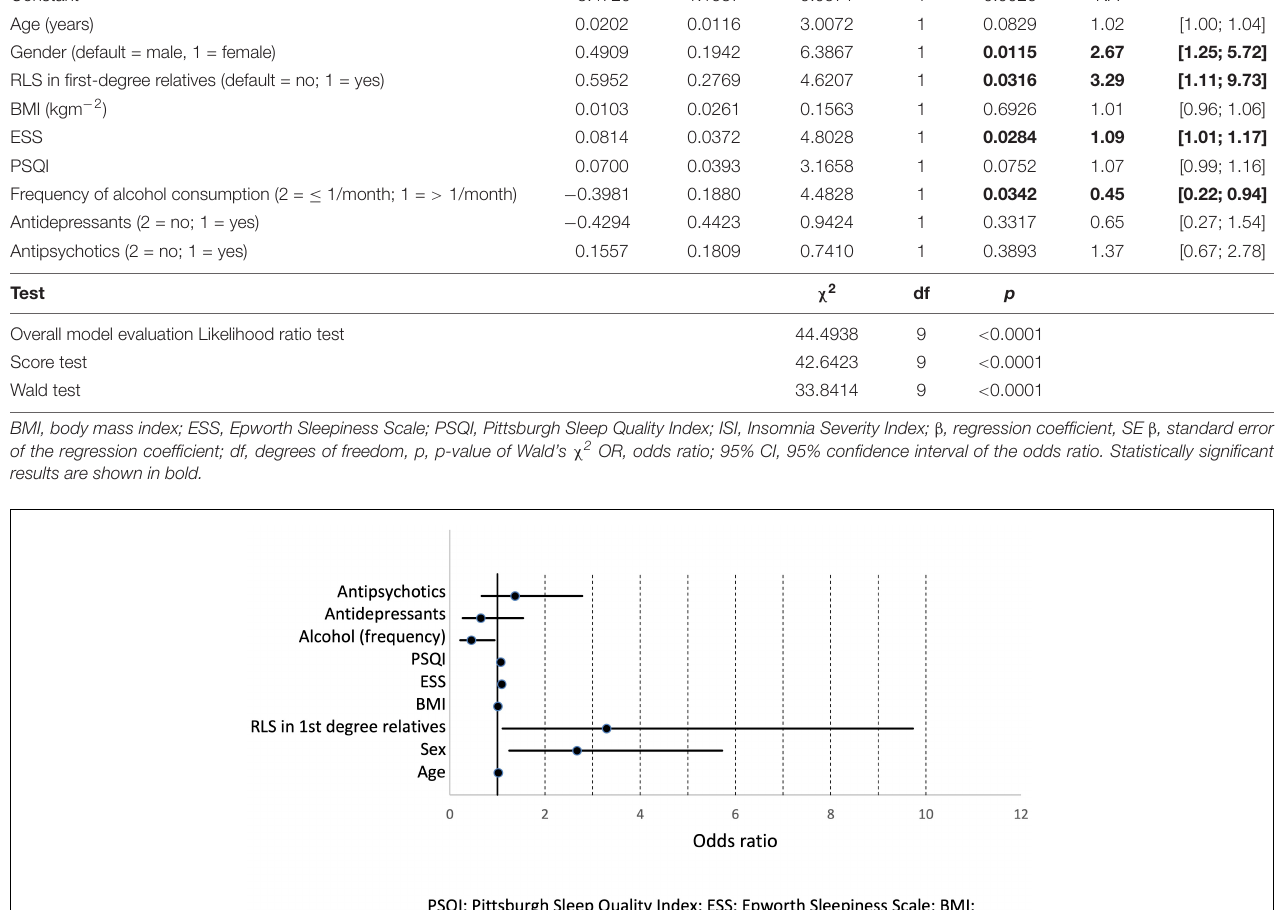
TABLE 5 | Results of logistic regression analysis of 299 patients for occurrence of restless legs syndrome (RLS; 50 patients with and 249 without RLS). Variable/predictor β SE β Wald’s χ 2 df p OR Constant